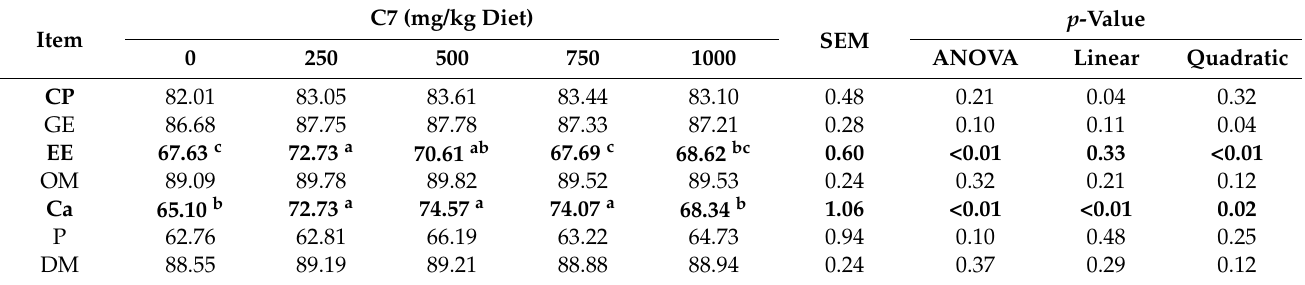
Table 7. Effects of dietary C7 supplementation on nutrients’ apparent total tract digestibility